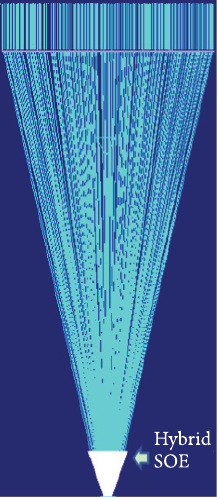
Figure 3: Schematic diagram of ray tracing at deflection angle 0 ∘ .